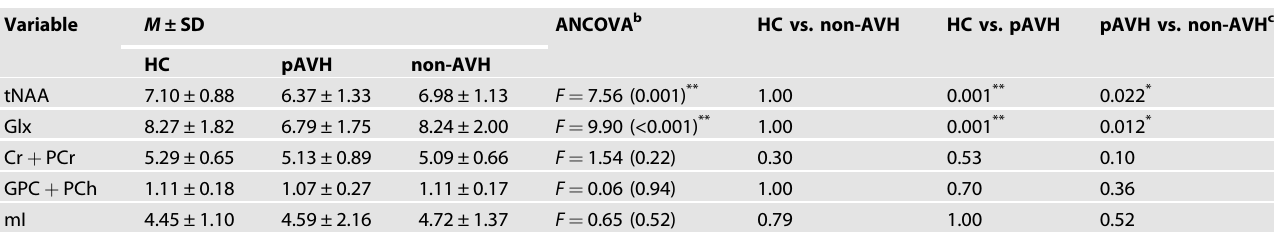
The three columns on the right-hand side are results of post-hoc tests, Bonferroni corrected. M Mean, SD standard deviation, pAVH persistent auditory verbal hallucinations, non- AVH without auditory verbal hallucinations, HC health control, ANCOVA